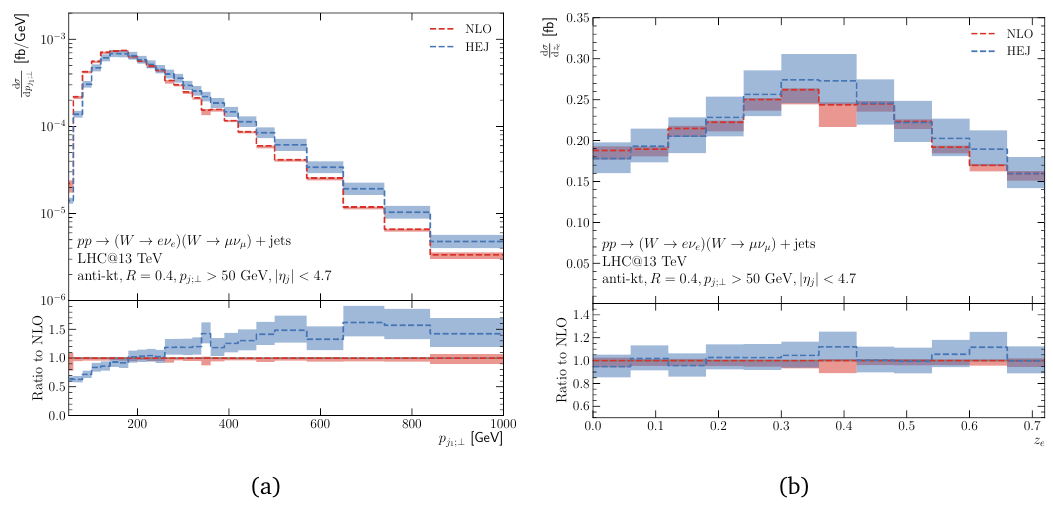
Figure 4: Differential distributions in the transverse momentum of the leading jet (a) and in the Zeppenfeld variable for the electron